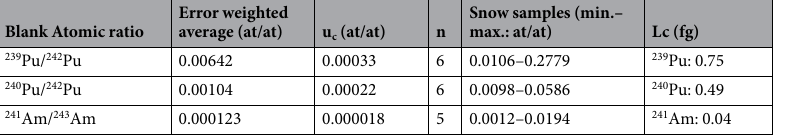
Table 1. Error weighted averages of blank values, u c : combined uncertainty; at: number of atoms, n: number of samples, L